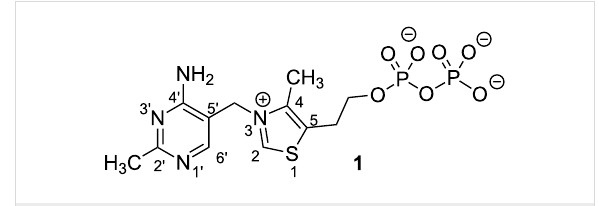
Figure 1: Structure of thiamine diphosphate (ThDP, 1